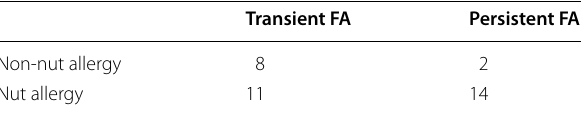
Table 1 Allergy groups associated with nut and non‑nut